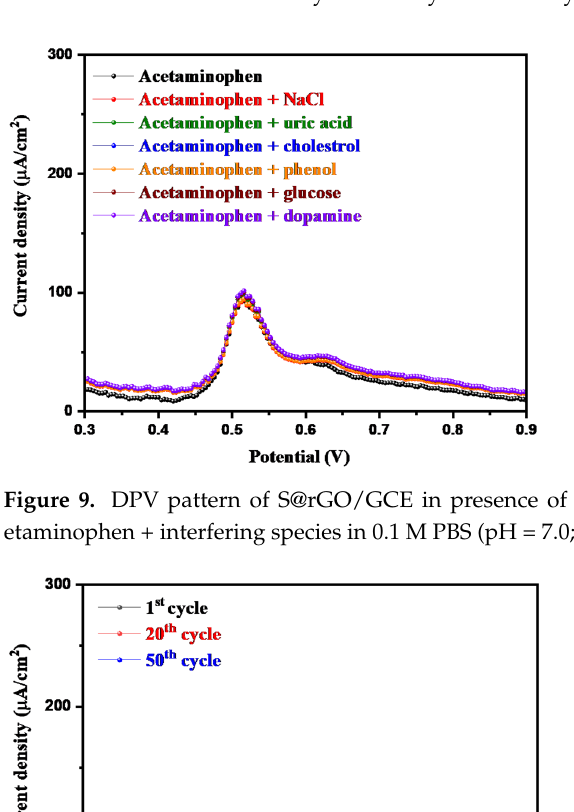
Figure 9. DPV pattern of S@rGO/GCE in presence of 100 µM acetaminophen and 100 µM acetamino-